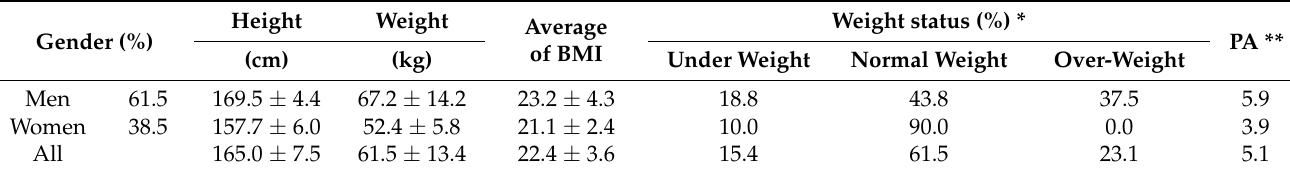
Table 3. Basic characteristics of